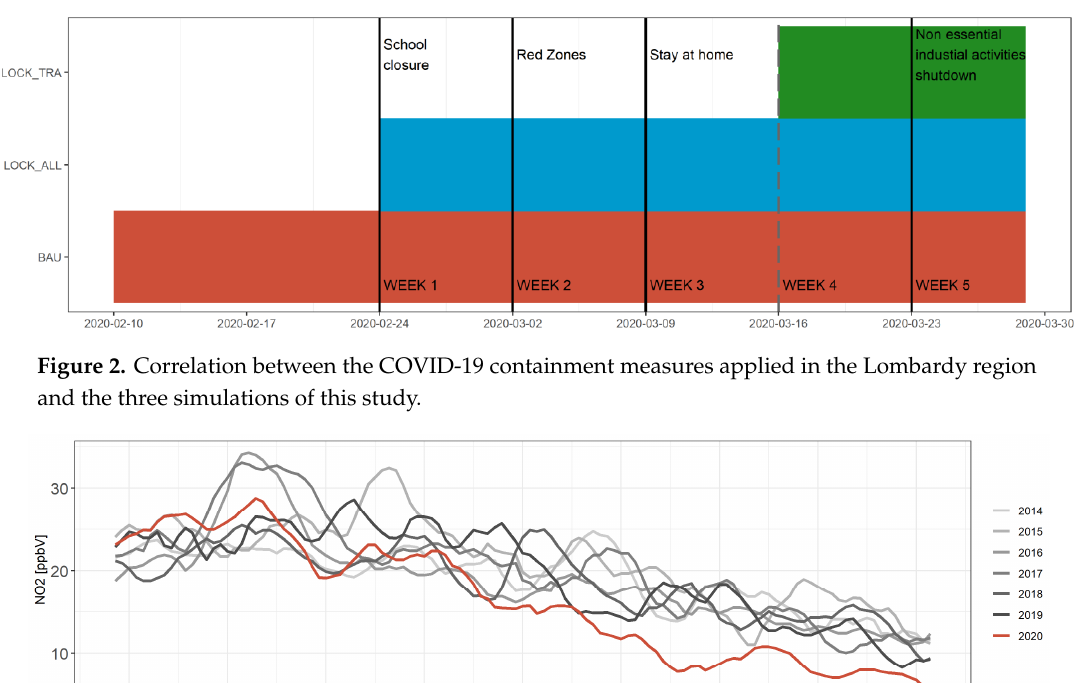
Figure 2. Correlation between the COVID-19 containment measures applied in the Lombardy region and the three simulations of this study.